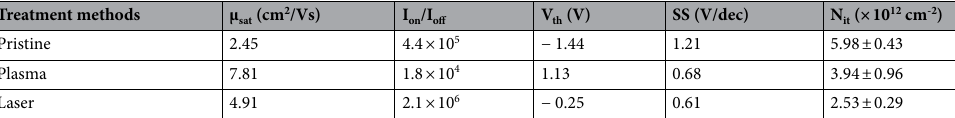
Table 1. Electrical performance of multi-stack IZO TFTs with pristine, plasma, and laser